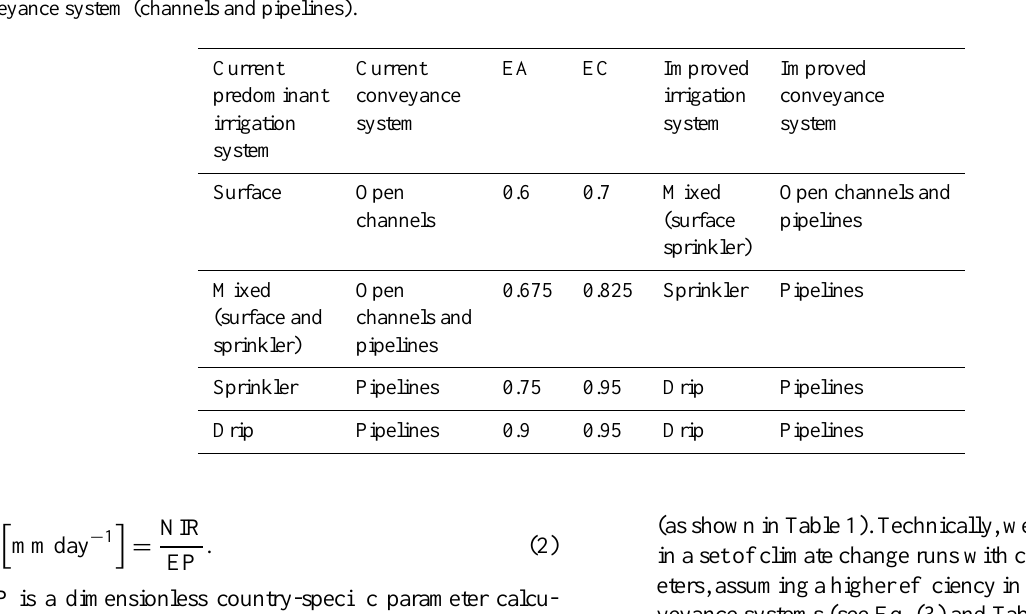
Table 1. Left four columns: efficiencies linked to irrigation and conveyance systems. EA: field application efficiency. EC: conveyance efficiency. Right two columns: explanation of the implementation of the improved irrigation scenario (IMP). For example, a country with surface irrigation and open channels, will, in the IMP scenario, move to a combination of surface and sprinkler irrigation and to mixed- conveyance system (channels and